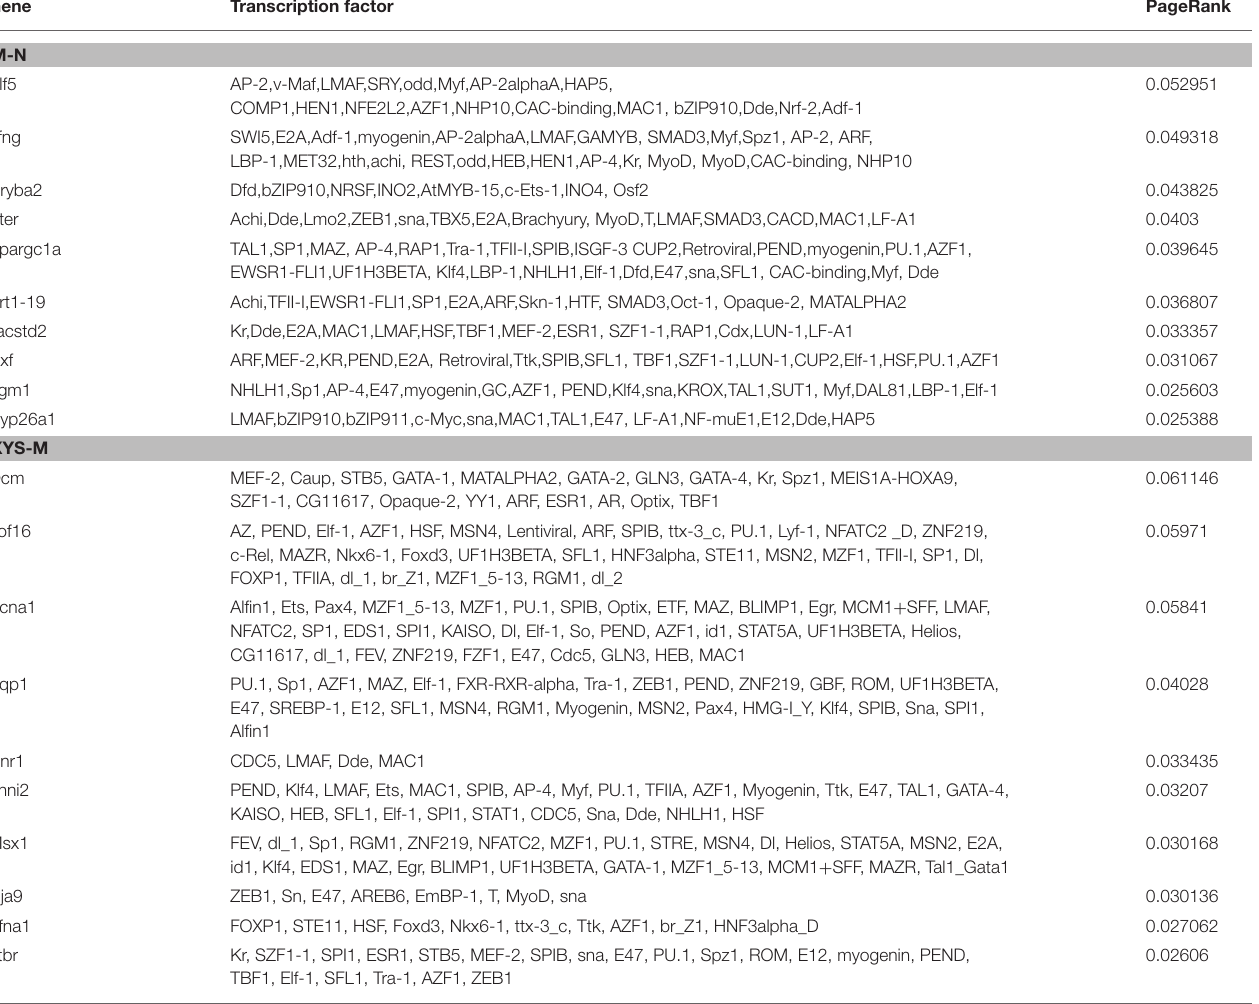
TABLE 5 | PageRank values of the first 10 core genes in the network structure diagram and their common